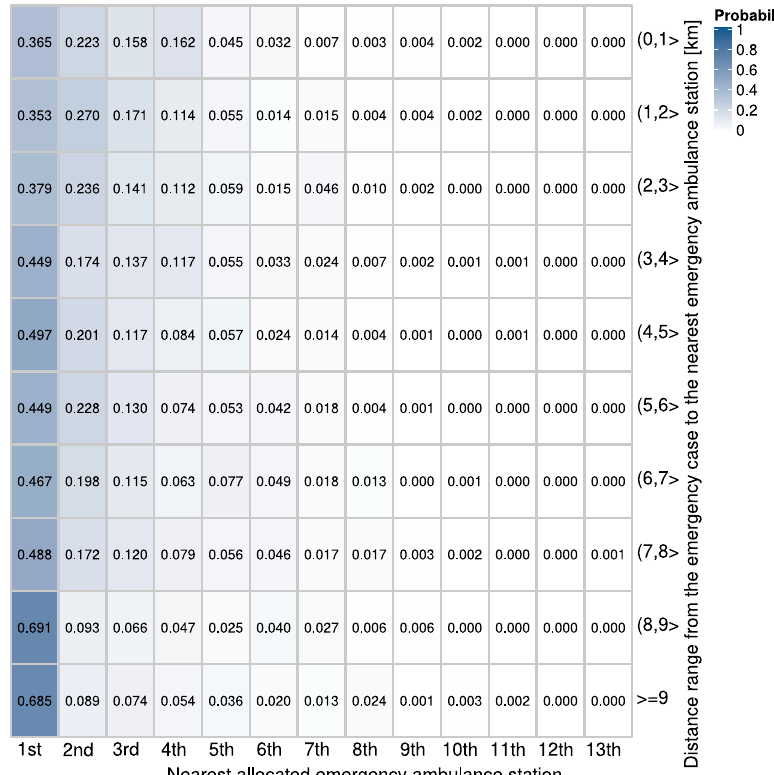
Figure 8. The empirical probability distributions of emergency cases to be allocated to the k-th nearest ambulance station (in each row, we present the distribution for a range of the distance from an emergency case location to the nearest emergency ambulance station). In the evaluations, we used the Euclidean